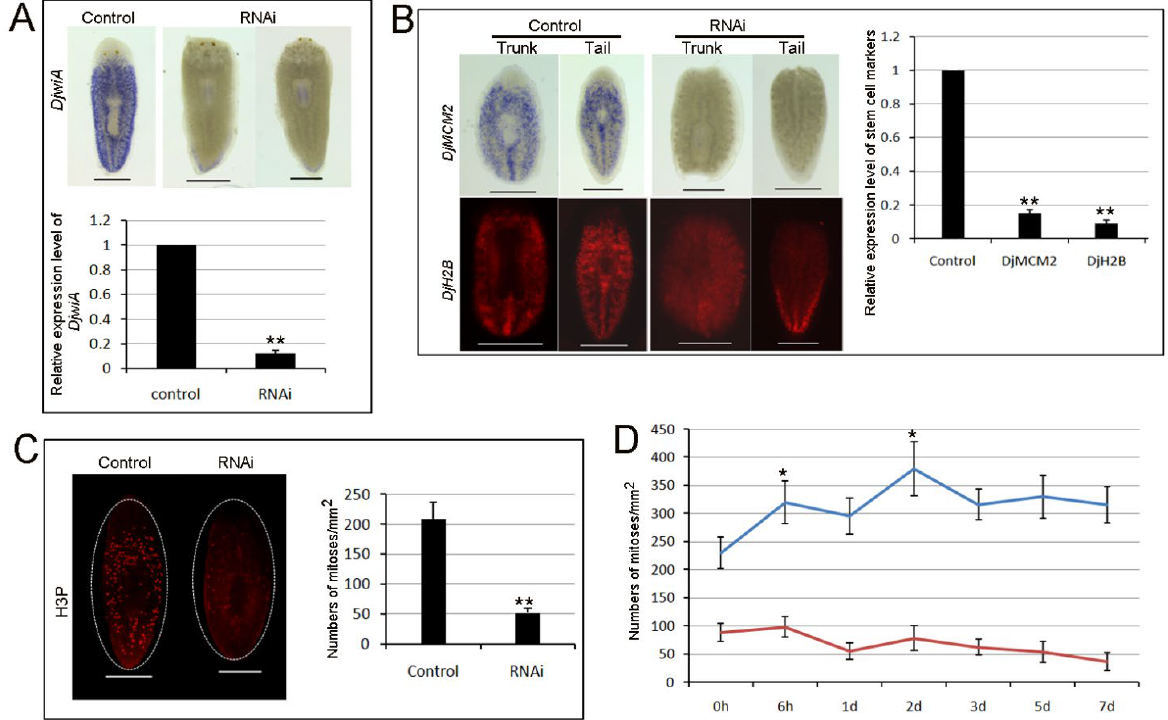
Figure 4. RNAi- Djhsp60 affects stem cell function. ( A ) Expression of DjwiA after RNAi in intact animals revealed by WISH and qRT-PCR. Color development for 45 min., n = 6 animals. ( B ) Expression of stem cell markers revealed by WISH, FISH and qRT-PCR after RNAi at 5 days of regeneration. Color development for 45 min., n = 6 animals. ( C ) Representative of images labeled with anti-H3P and quantification of mitotic cells in intact control and RNAi animals. ( D ) Dynamic changes of mitotic cells after RNAi at different time points post-amputation. Asterisks indicate statistical differences (* p < 0.05, ** p < 0.01). Scale bar: 0.5 mm.